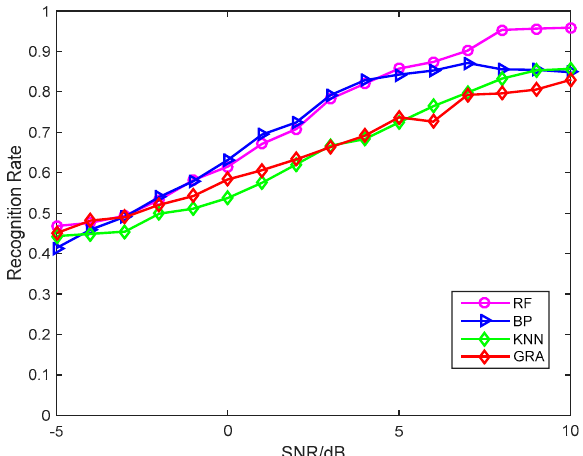
Figure 7. Recognition rate curve under different SNRs.